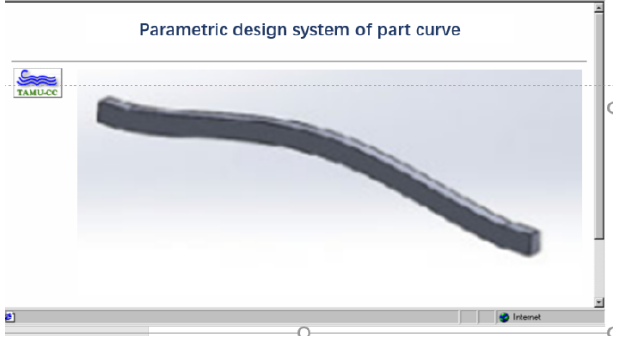
Fig. 11 3D model of the curved